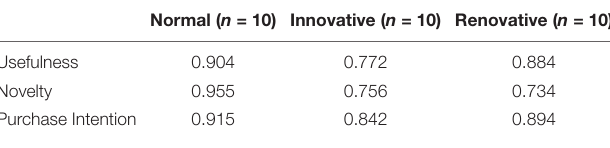
TABLE 1 | In Experiment 1, Cronbach’s α coefficients of usefulness, novelty, and purchase intention variables of three types of